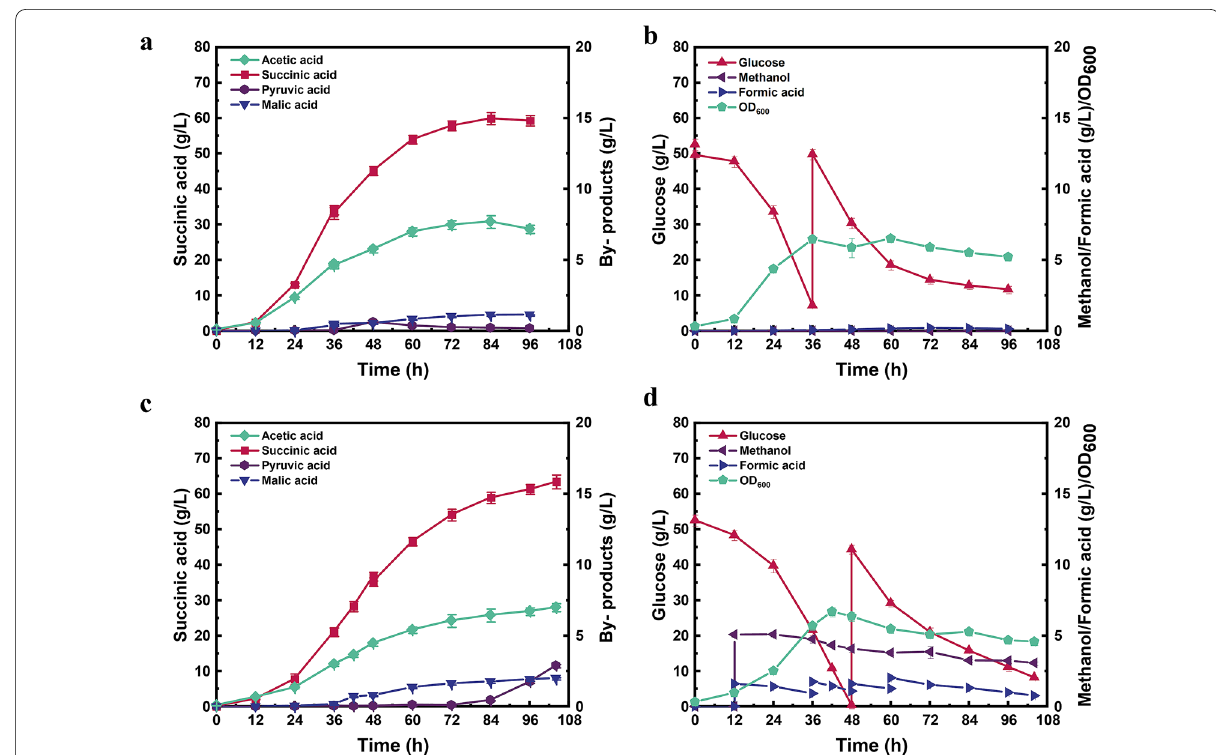
Fig. 3 a , b Fed-batch fermentation of strain G4 with pure glucose feeding. c , d Fed-batch fermentation of strain G4 with methanol and sodium formate